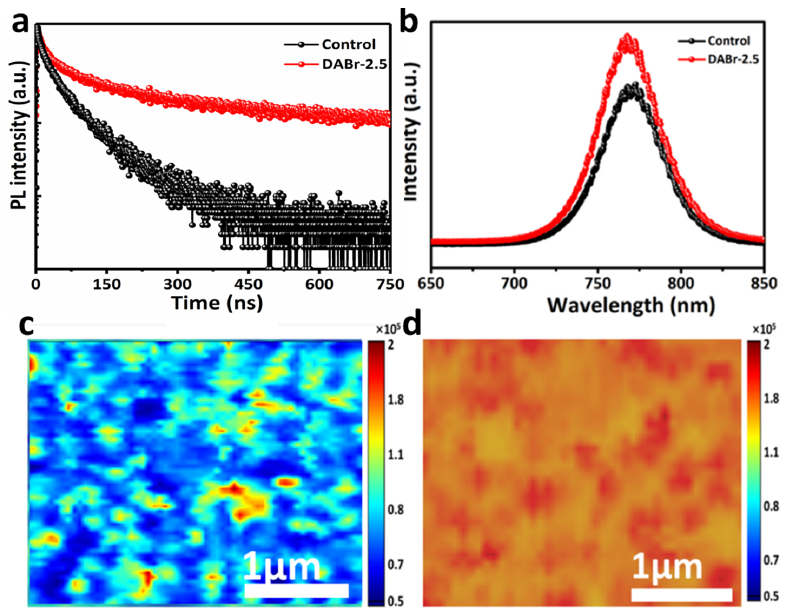
Figure 4. ( a ) Time-resolved photoluminescence (TRPL) and ( b ) steady-state photoluminescence (PL) of the control and DABr-2.5 films deposited on glass. ( c ) Single-point PL spectral intensity mappings images of the control and ( d ) DABr-2.5 films.